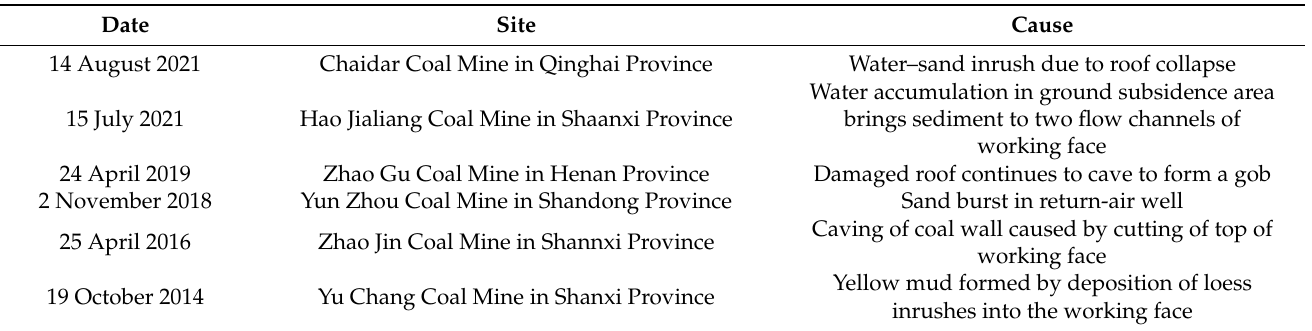
Table 1. Water–sand inrush accidents in China in recent 10